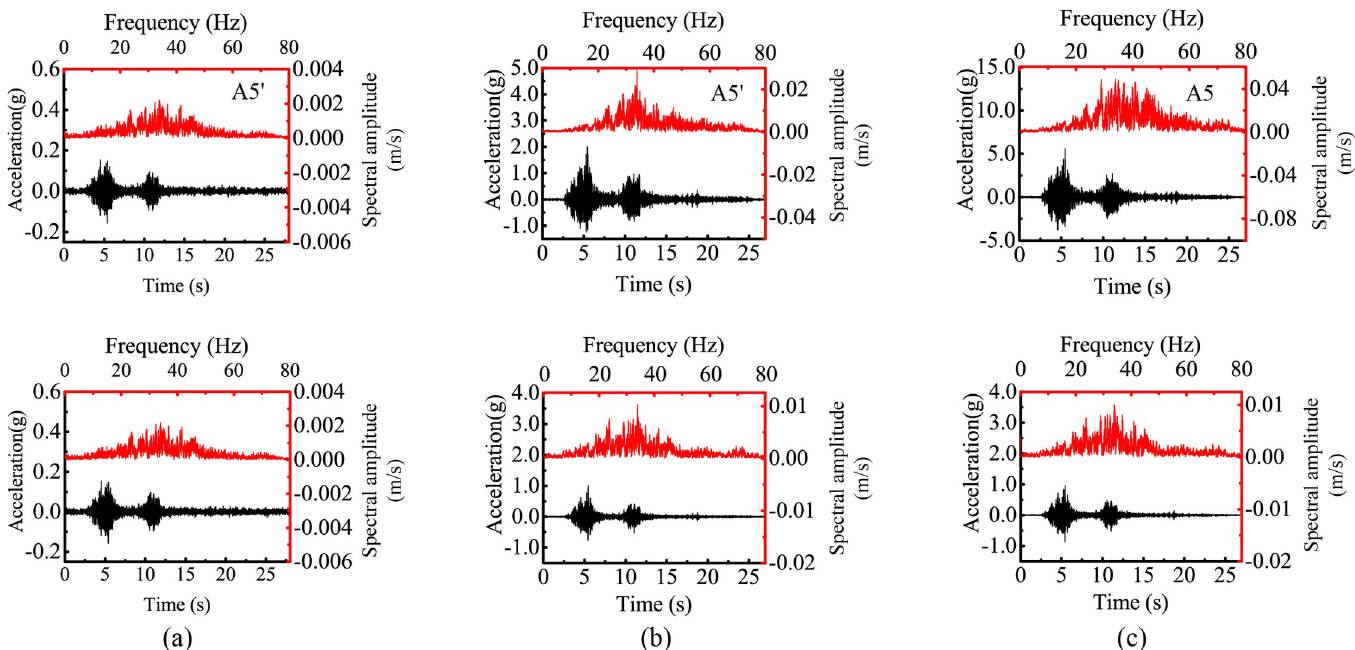
Fig 8. Vertical acceleration responses at two monitoring points of two model slopes under 0.1 g and 0.6 g levels of vertical shaking: (a) input amplitude = 0.1 g, slope A; (b) input amplitude = 0.6 g, slope A; (c) input amplitude = 0.6 g, slope